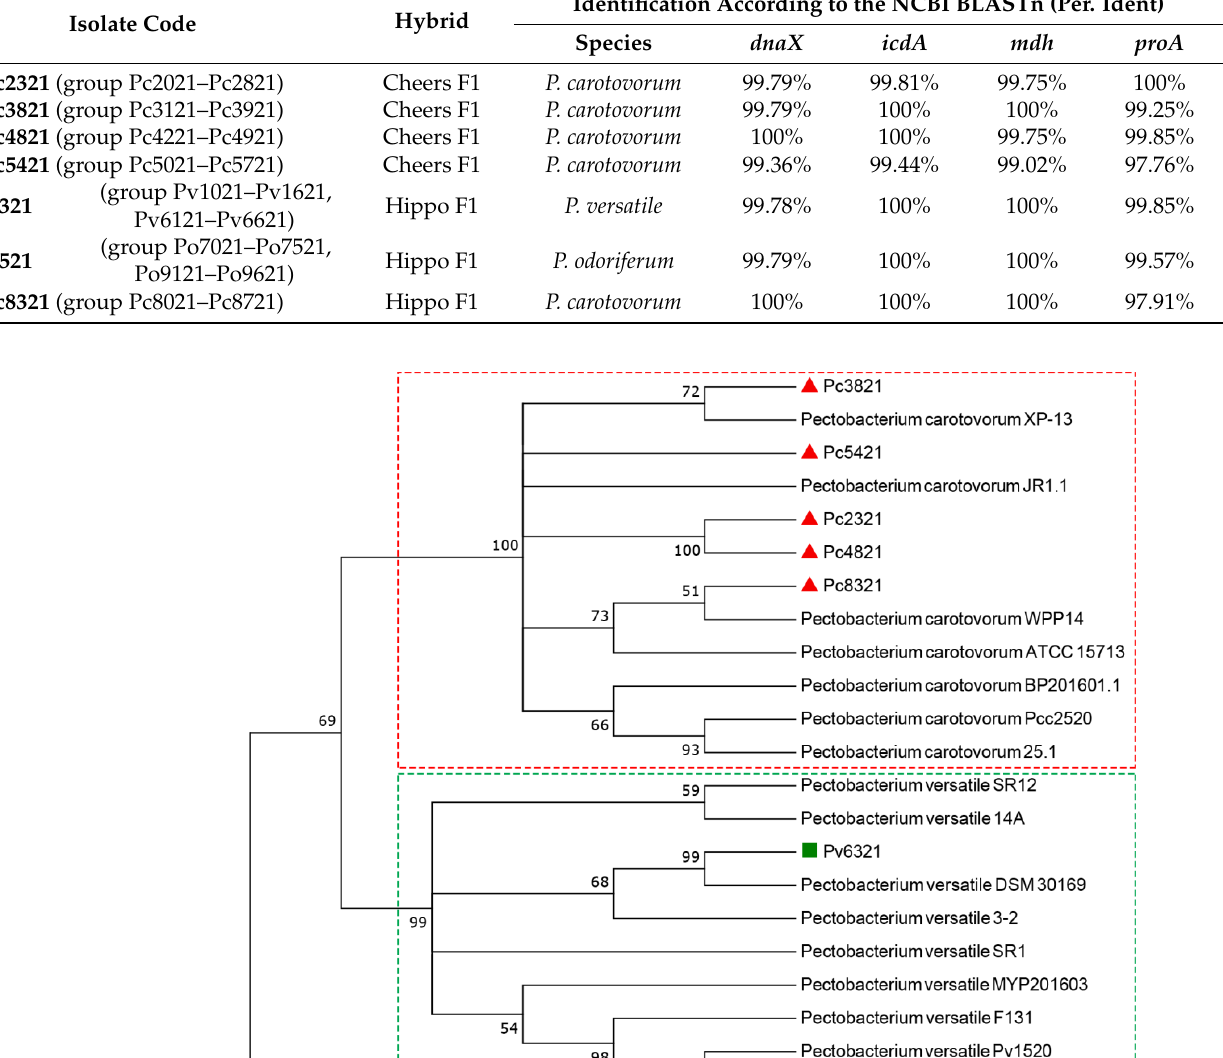
Table 4. The list of the 67 Serbian cabbage Pectobacterium spp. isolates and species affiliation, with the percent identity of the sequenced isolates based on the partial sequences of four sequenced genes ( dnaX , icdA , mdh , and proA ).